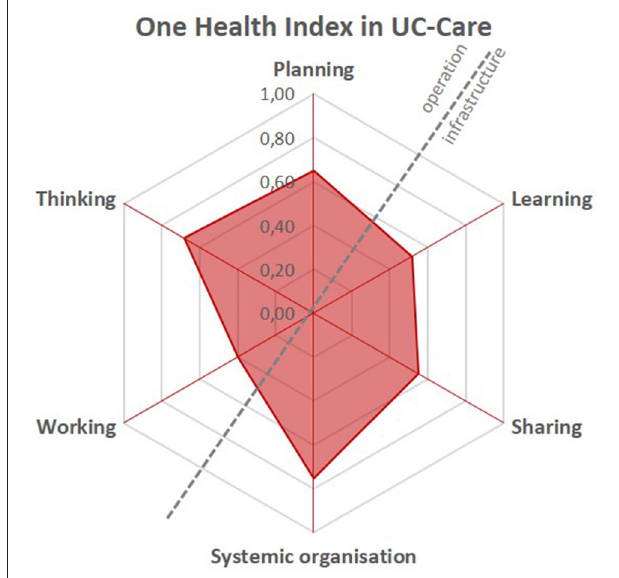
FIGURE 4 | Spider diagram representing the scores allocated to the elements Thinking, Planning, Working, Learning, Sharing and Systemic organization of the OH-ness assessment of UC-CARE on a scale from 0 to 1 for each